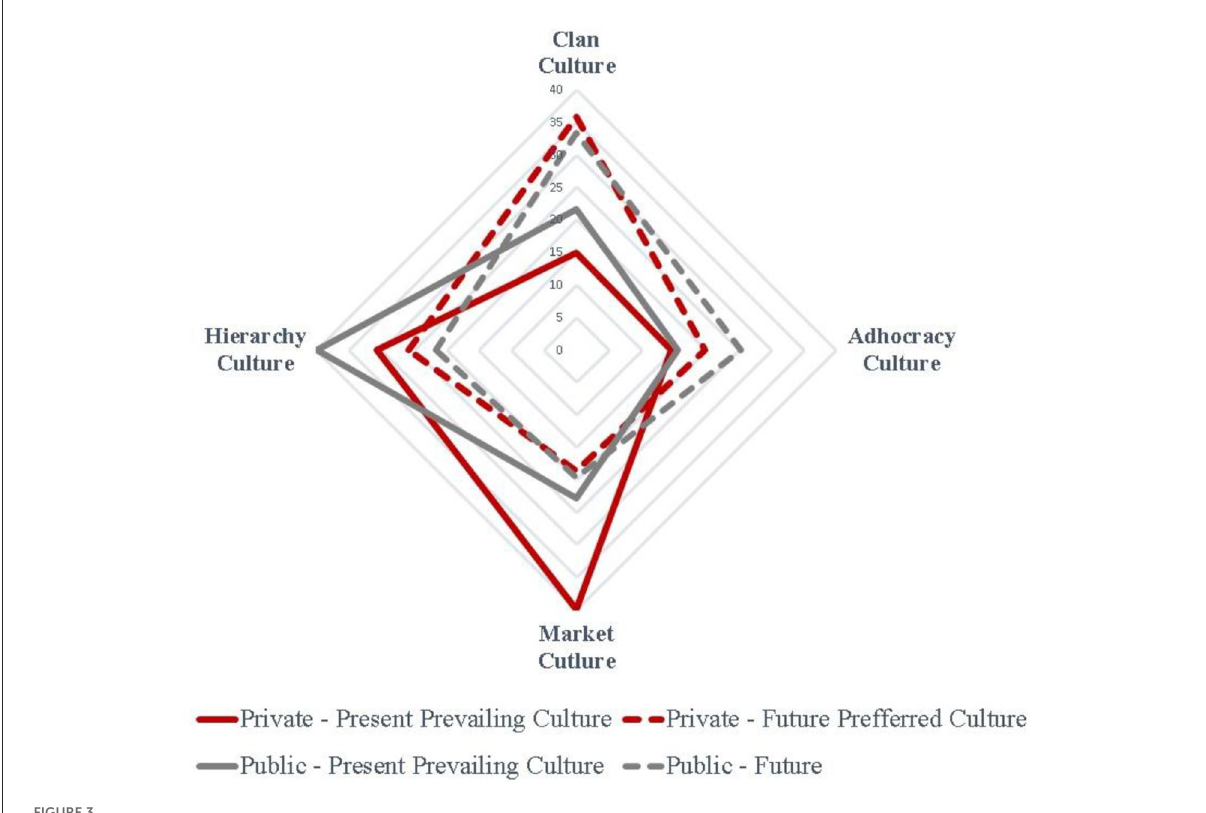
FIGURE3 Current and desired organizational culture in private and public sectors of the Greek economy. Lampos, 2016; Gkila, 2017; Vassilakopoulou, 2017; Tsegkou, 2018; Zervea et al., 2021, processed by